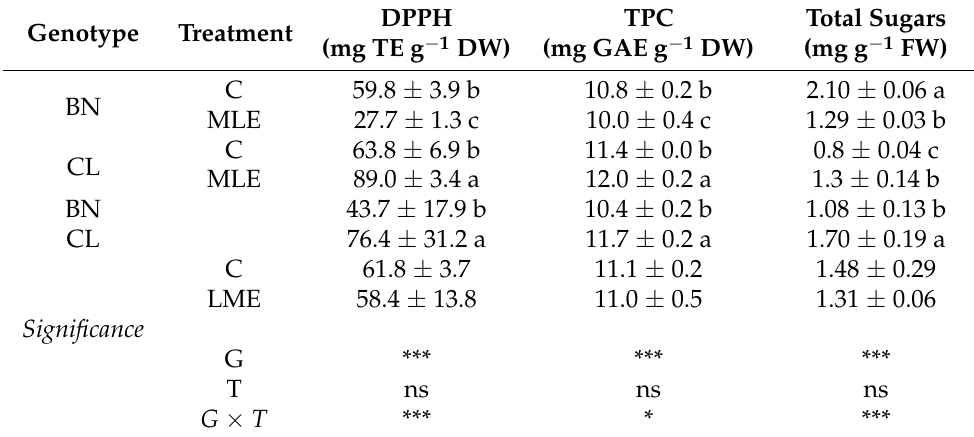
Table 5. Effect of MLE application on antioxidant activity, DPPH (mg TE g − 1 DW), total polyphenols,